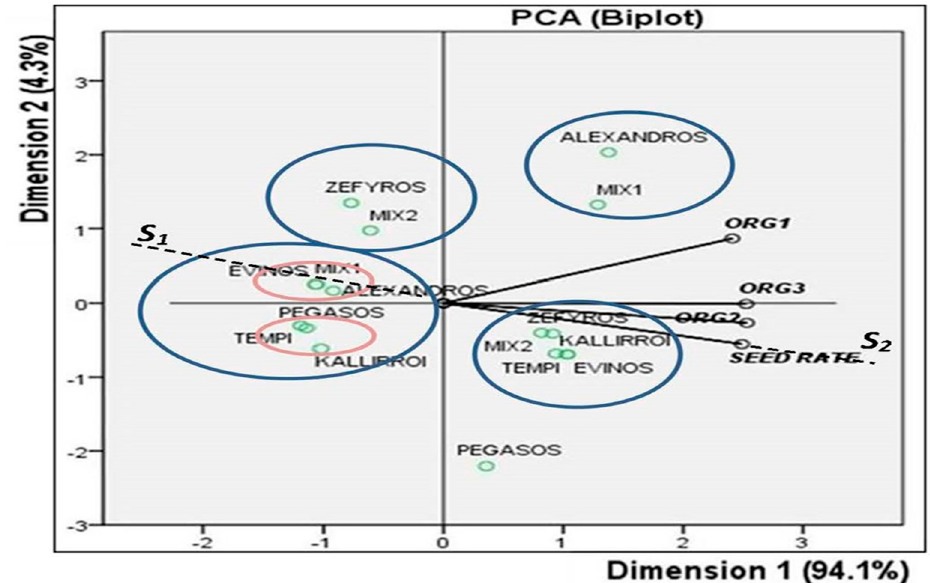
Figure 5 . PCA biplot analyses of decomposition percentage of organic matter two (ORG 1 ), four (ORG 2 ) and six months (ORG 3 ) after the incorporation of biomass for six cultivars and two mixtures of common vetch at two seed rates (S 1 : 100 kg ha − 1 ; S 2 :180 kg ha − 1 ). A significant effect ( p < 0.05) of seed rate on decomposition of organic matter of com- mon vetch plants was observed in the two-month period. Likewise, significant differences ( p < 0.05) were detected among cultivars in the same time period, as resulting from Tukey’s analysis. Specifically, decomposition rate of green manure of the cultivars Alexandros and Tempi and the mixtures Mix1 and Mix2 was significantly affected ( p < 0.05) by seed rate. The higher rate of decomposition was recorded by cv. Tempi at the S 1 seed rate (viz. 42.8%) and by cultivar Alexandros (viz. 42%) at the S 2 seed rate. It is interesting to note that plant tissue of cv. Tempi decomposes to a greater extent at the lower seed rate not only in the two-month period after green manure management, but also in the four- and six-month